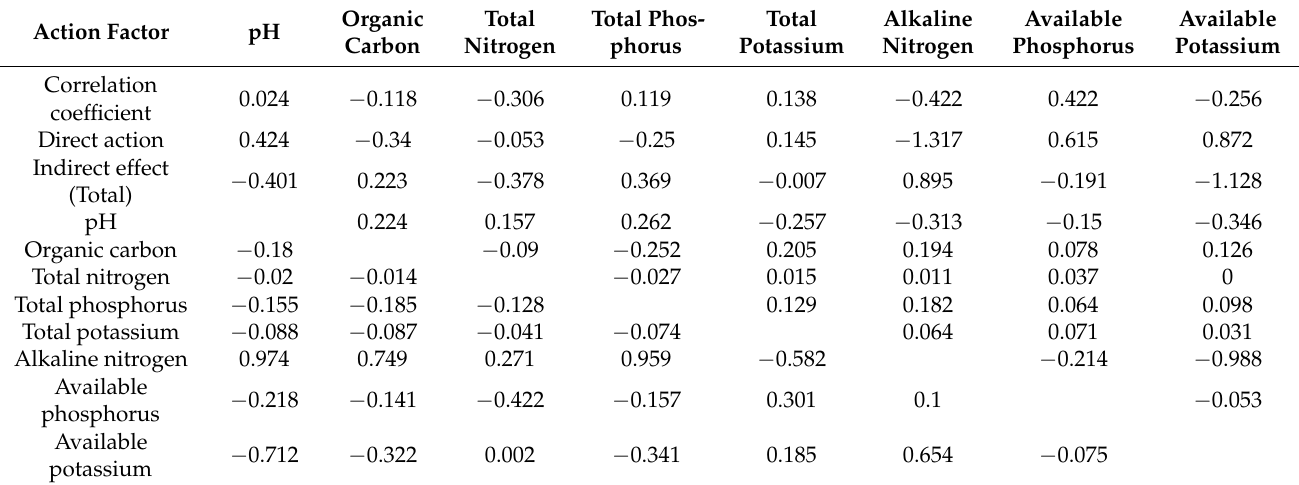
Table 2. Path coefficients of the physical and chemical properties of the soil surface for the phosphorus content in the new shoots of